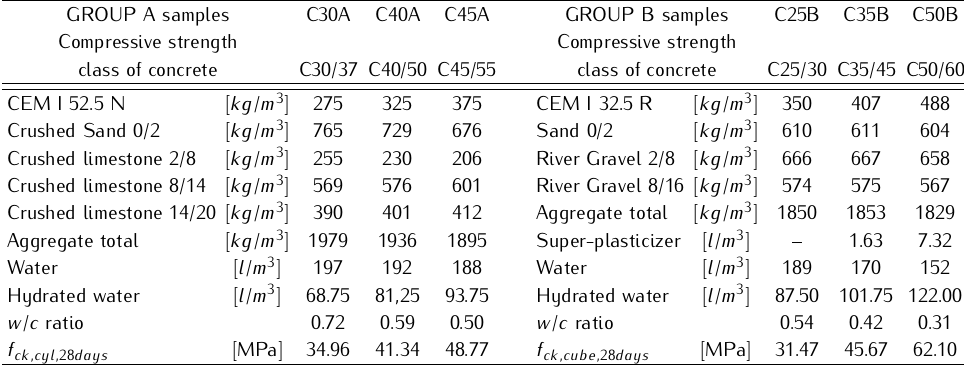
Table 4. Concrete compositions of different compressive strength class for SPOT simulations.